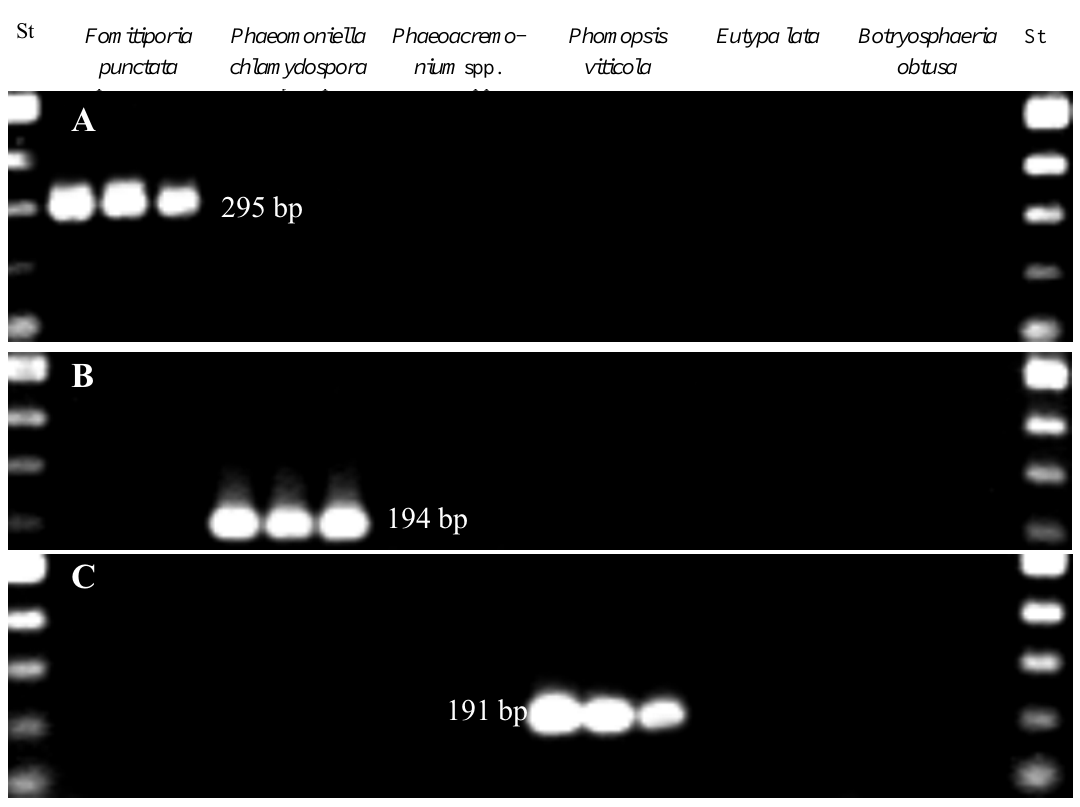
Fig. 5. Example of SCAR primer specificity. Each electrophoretic line represents a different isolate. The PCR ampli- fications depended on the specific primer pair used for the detection of Fomitiporia punctata (A), Phaeomoniella chlamydospora (B) and Phomopsis viticola (C). St, standard.